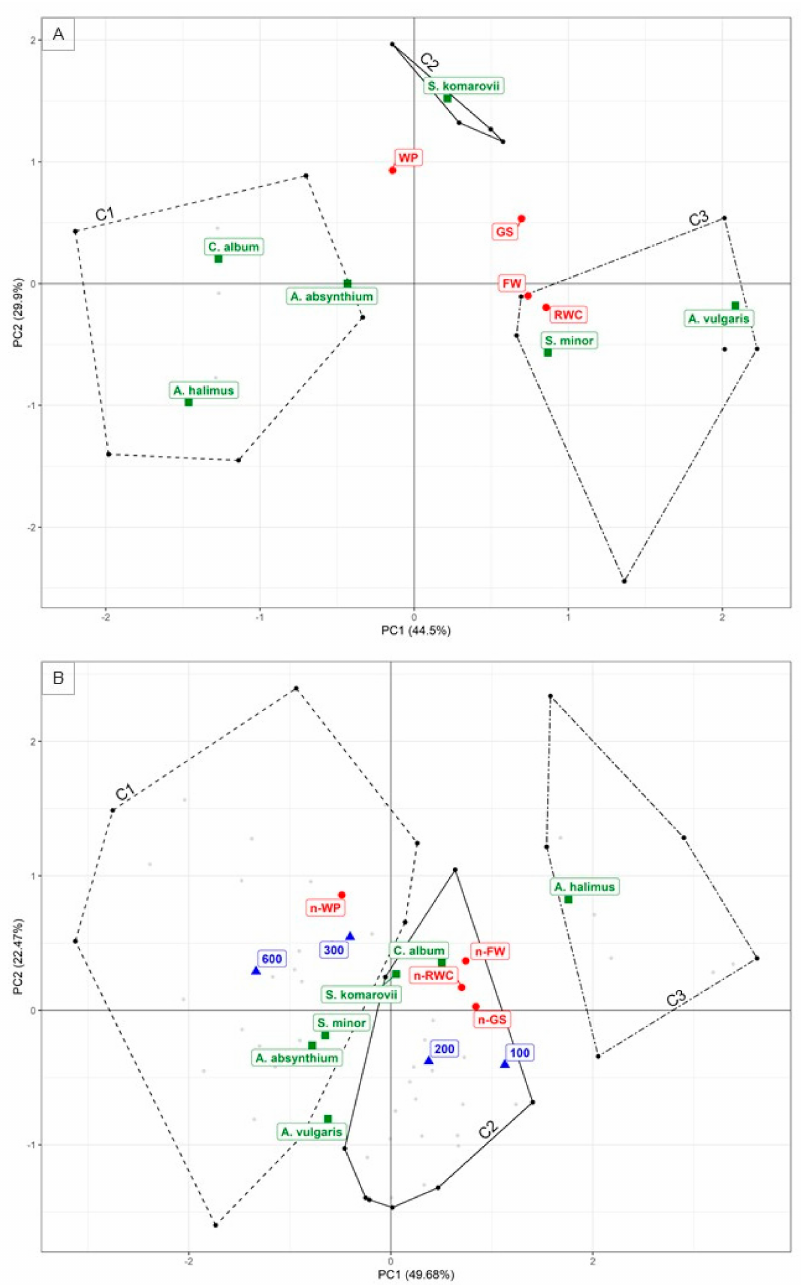
Figure 3. ( A ) Control and ( B ) Control-normalized principal component analysis (PCA) biplot of variables. Green points show the barycenters of the halophytes species (HS), blue point show the barycenters of the saline treatments (WS), red points show the quantitative variables, i.e., fresh weight (FW), stomatal conductance (GS), leaf relative water content (RWC), and leaf water potential (WP). The lowercase n indicates control-normalized data. The polygons show the three extracted clusters in the first two PCs space. Grey dots represent the individuals of the two categorical variables, i.e., WS and HS. C1, C2 and C3 = Cluster 1, 2, and